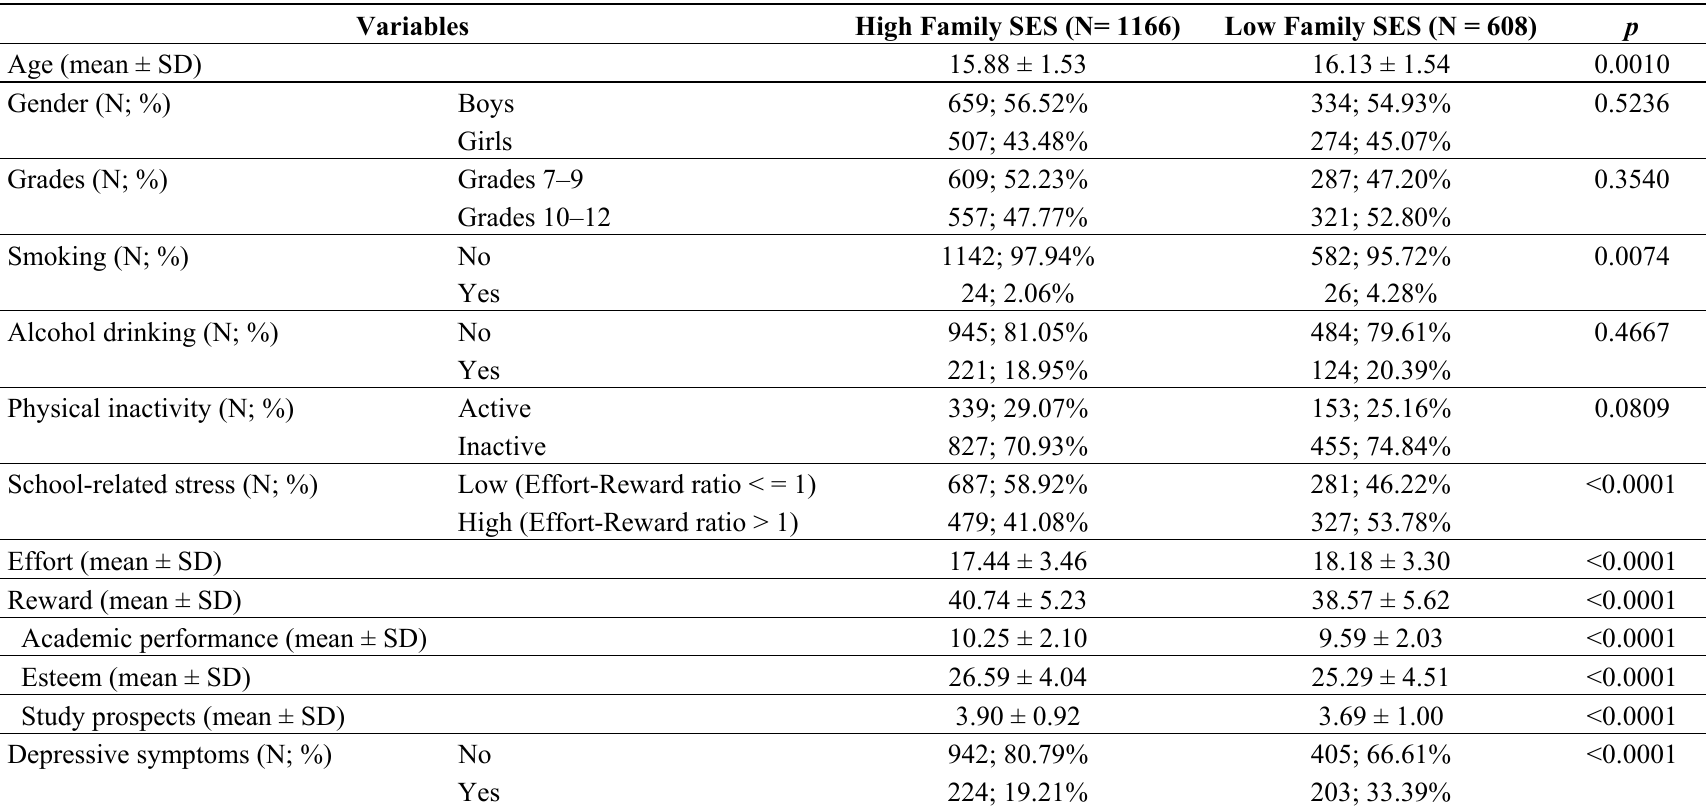
Table 1. Characteristics of the study